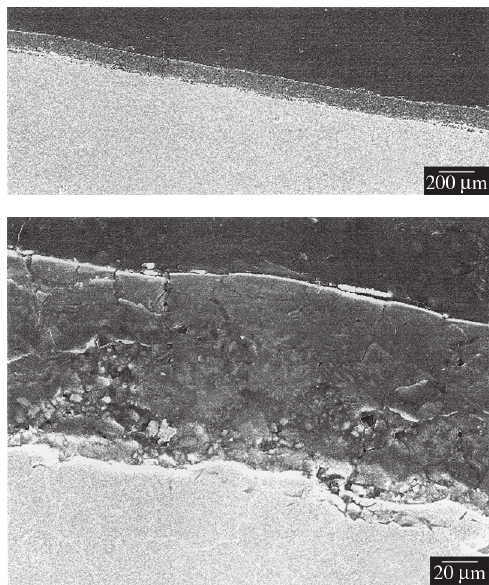
Figure 7. Scanning electron micrograph of the cross-section of the corrosion film formed on steel J4a during flow-loop